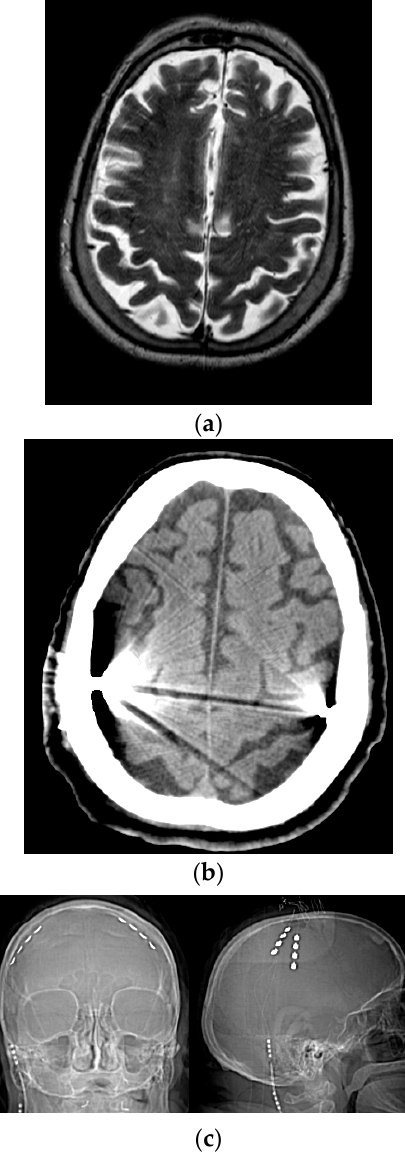
Figure 1. Placement of quadripolar electrode strips over the motor cortices. ( a ) Preoperative brain MRI. ( b ) Postoperative brain CT scan. ( c ) Postoperative skull X-ray. R = right; L = left.